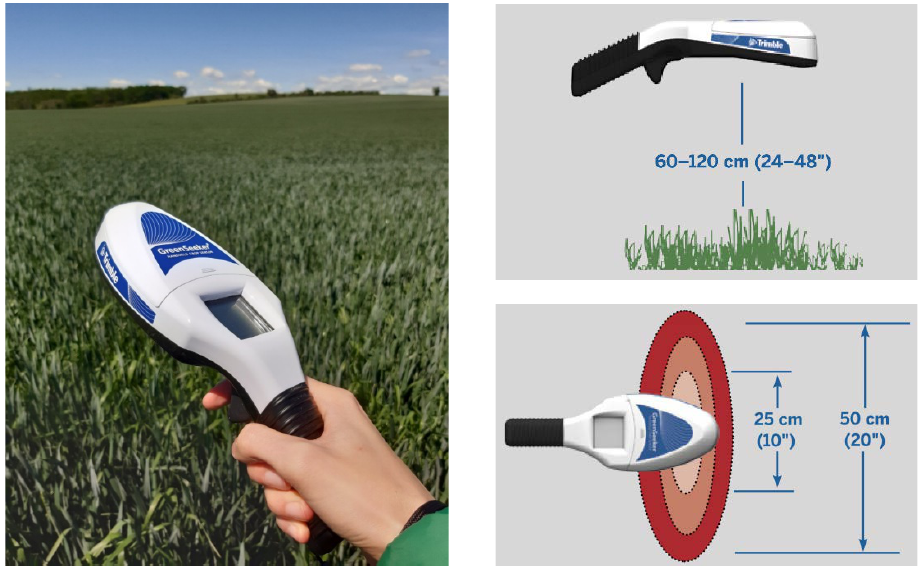
Figure 1. ( Left ) GreenSeeker spectrometer for ground measurements (photo: Paulina Raeva), ( right ) functionalities during NDVI field measurements.